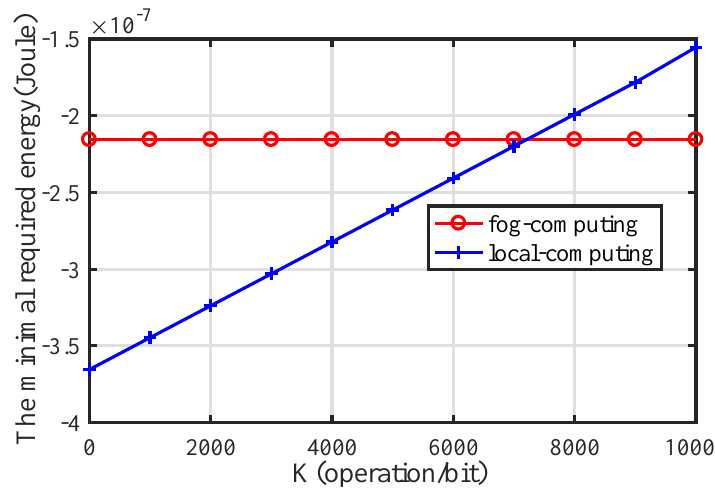
Figure 6. The minimal required energy versus K .